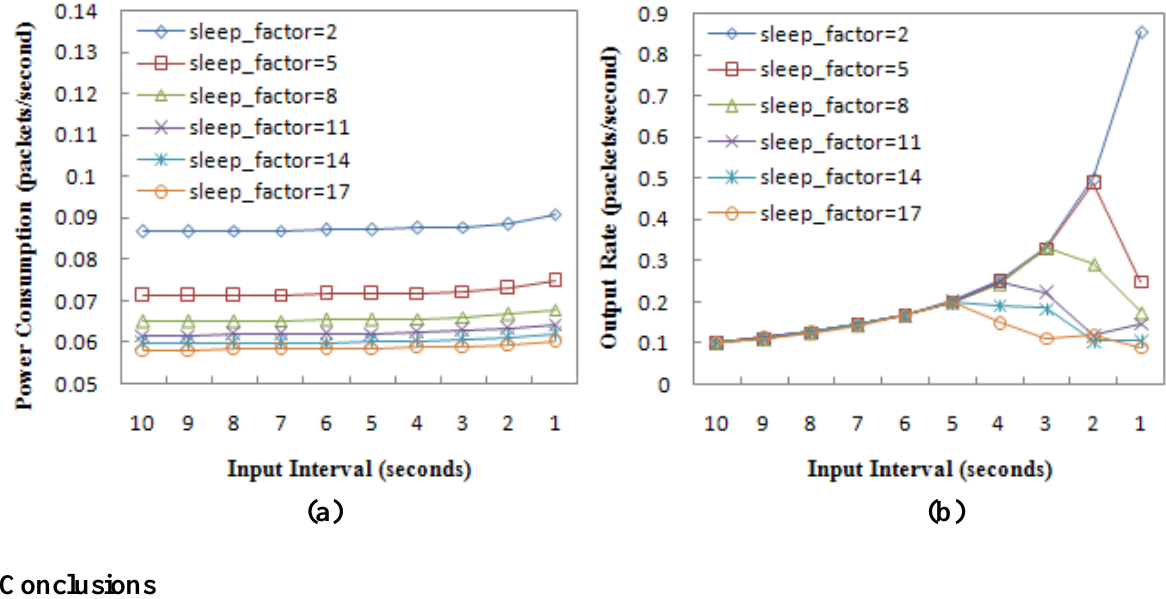
Figure 13. The impact evaluation of sleep_factor in the random topology, (a) Average power consumption. (b) Output